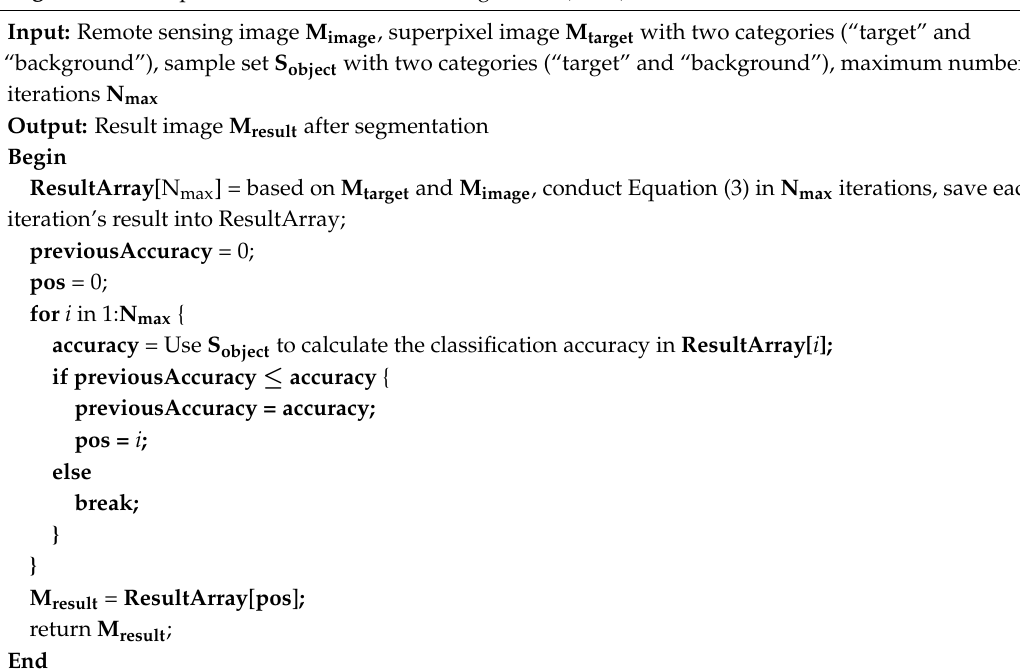
Algorithm 1 Sample-Based Iteration Control Algorithm